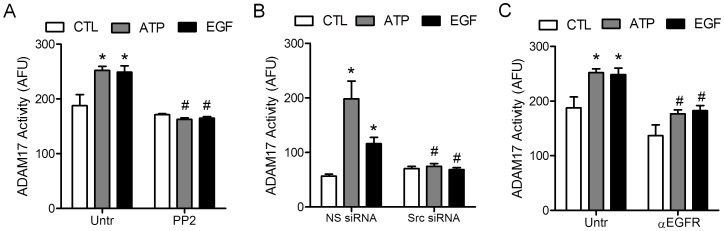
Exogenous ATP results in activation of ADAM17 via c-Src and EGFR ligand.H292 cells were preincubated with PP2 (A), Src-specific or control siRNA (B), or α-EGFR mAb (C) as in Figs 2 and 3, and stimulated with ATP (100 µM) or EGF (100 ng/ml) in the presence of a fluorogenic substrate specific for ADAM17, and changes in fluorescence were monitored after 2 hrs. *: p<0.05 compared to untreated control or NS siRNA; #:p<0.05 compared with corresponding stimulation in the absence of PP2, Src siRNA, or α-EGFR mAb (n = 4).